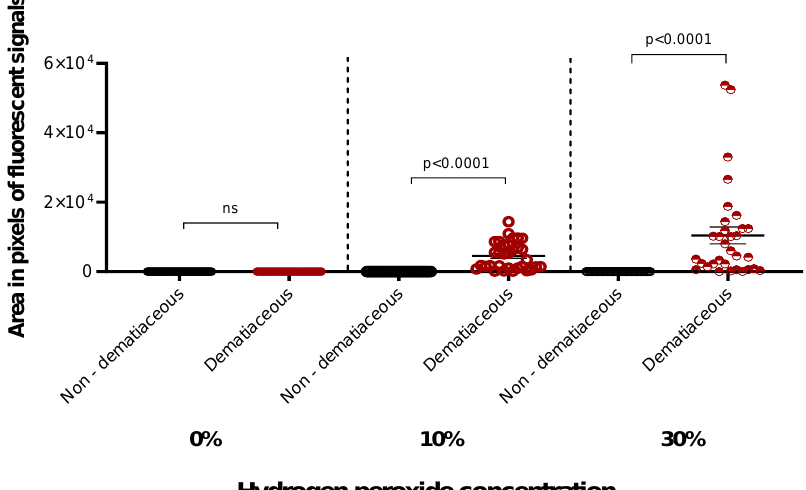
Figure 1. Comparison of fluorescence intensity measured as the area of pixels between dematiaceous molds and non-dematiaceous fungi with and without the addition of hydrogen peroxide. Graph shows individual values with mean ± SEM for each group. p values were calculated using the Mann–Whitney test. ns; non-significant.